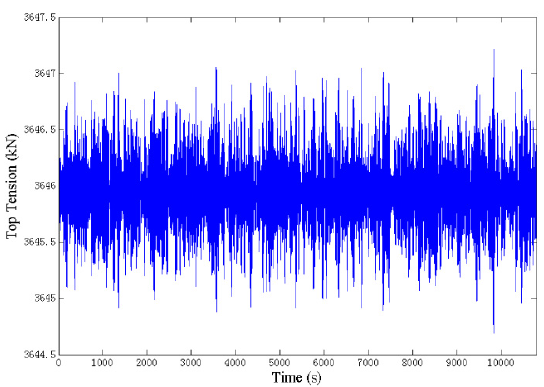
Figure 20. Top tension in time series (3 h) of single-component line. Table 2. The standard deviation of top tension for single-component case. In-House Orcaflex Standard deviation of Top Tension (N) 368.3